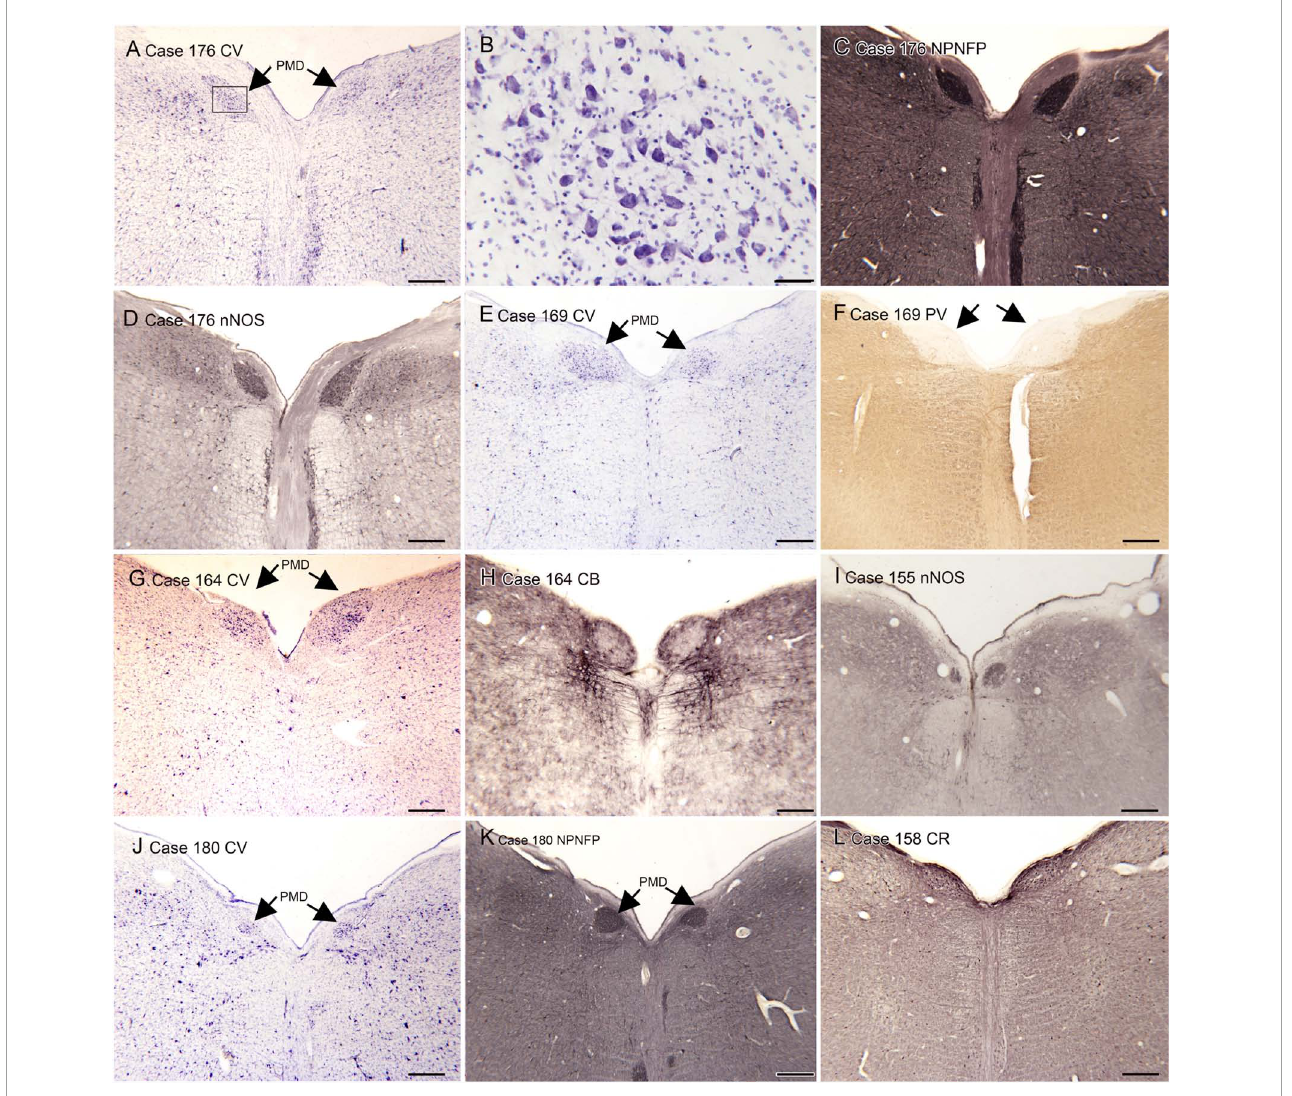
FIGURE1 The nucleus paramedianus dorsalis (PMD) in the human brain. (A) The arrows show the location of PMD on a CV-stained section from Case 176. The rectangle shows the location of the higher magnification image in panel (B) . (B) Neurons in the PMD are large and multipolar. (C) Immunoreactivity for non-phosphorylated neurofilament protein (NPNFP) in PMD; the nucleus is darkly labeled. Note the difference in shape between left and right sides. (D) nNOS expression in PMD. (E) The arrows indicate PMD in Case 169 shown on a CV-stained section. Note that it is larger on the left than on the right. (F) The arrows indicate PMD; note the absence of immunoreactivity to PV of neurons in PMD. (G) The arrows indicate PMD in Case 164. There is a slight difference in shape between left and right sides. (H) Neurons in PMD do not express the calcium-binding protein calbindin (CB). (I) Expression of nNOS in PMD of Case 155. (J) PMD in Case 180; in this case the nucleus is smaller and almost round. (K) The neurons and processes in PMD express non-phosphorylated neurofilament protein; the shape of the nucleus is much easier to see in the immunostained section. (L) Neurons in PMD